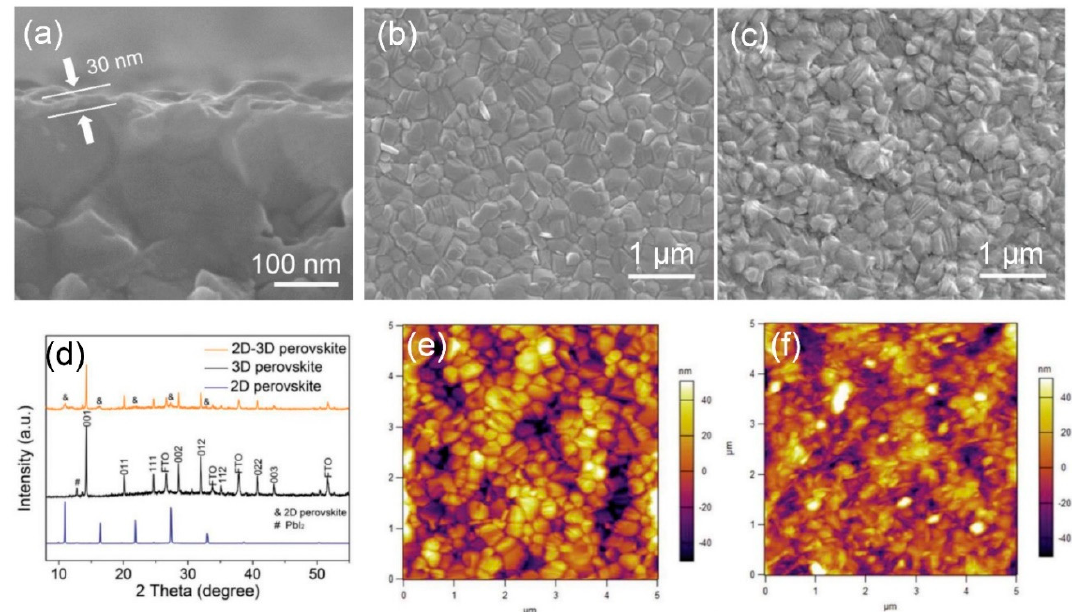
Figure 4. General morphology changes caused by the in-situ growth of the 2D capping layer. ( a ) Cross-sectional scanning electron microscope (SEM) image of the 3D/2D bilayered perovskite structure. Surface SEM images of ( b ) the 3D perovskite film and ( c ) 3D/2D bilayered structure with the in-situ-grown 2D capping layer. ( d ) X-ray diffraction (XRD) patterns of the respective structure. Atomic force microscope (AFM) images of ( e ) the 3D perovskite film and ( f ) 3D/2D bilayered structure with the in-situ-grown 2D capping layer. Reprinted with permission from Ref. [28] Copyright 2018 Wiley-VCH.